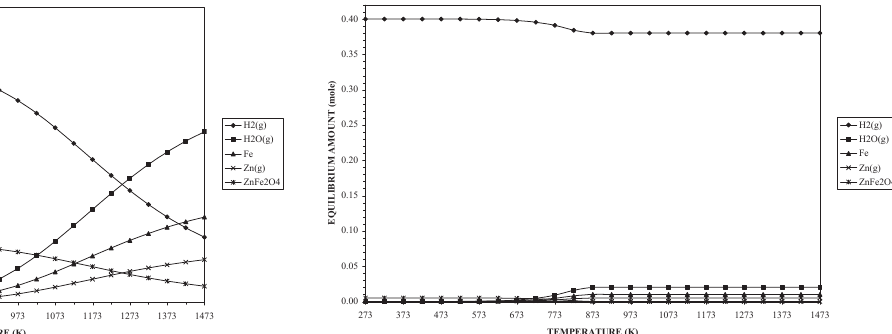
Figure 6. Equilibrium amounts of zinc ferrite with zinc and iron products as a function of temperature in the presence of 20 times over the stoichimetric amount hydrogen and water